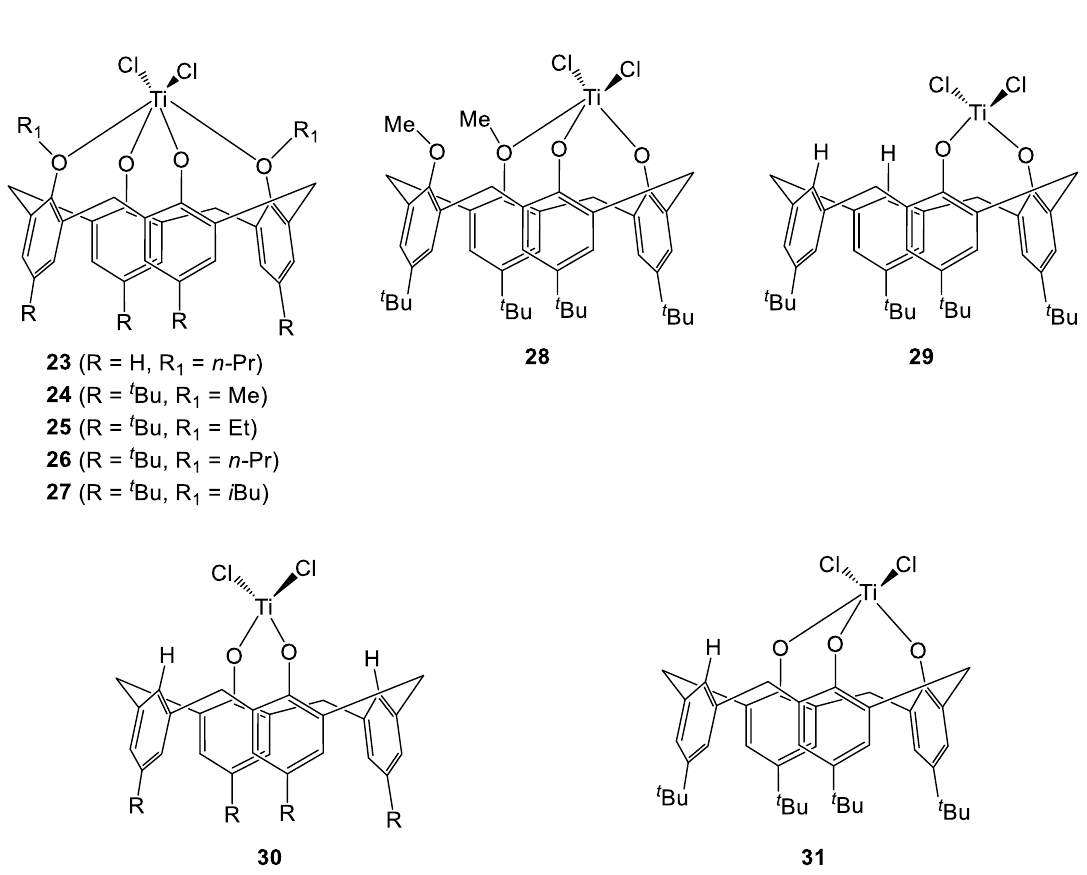
Figure 7. Proximal and distal titanocalix[4]arene complexes [13–15].